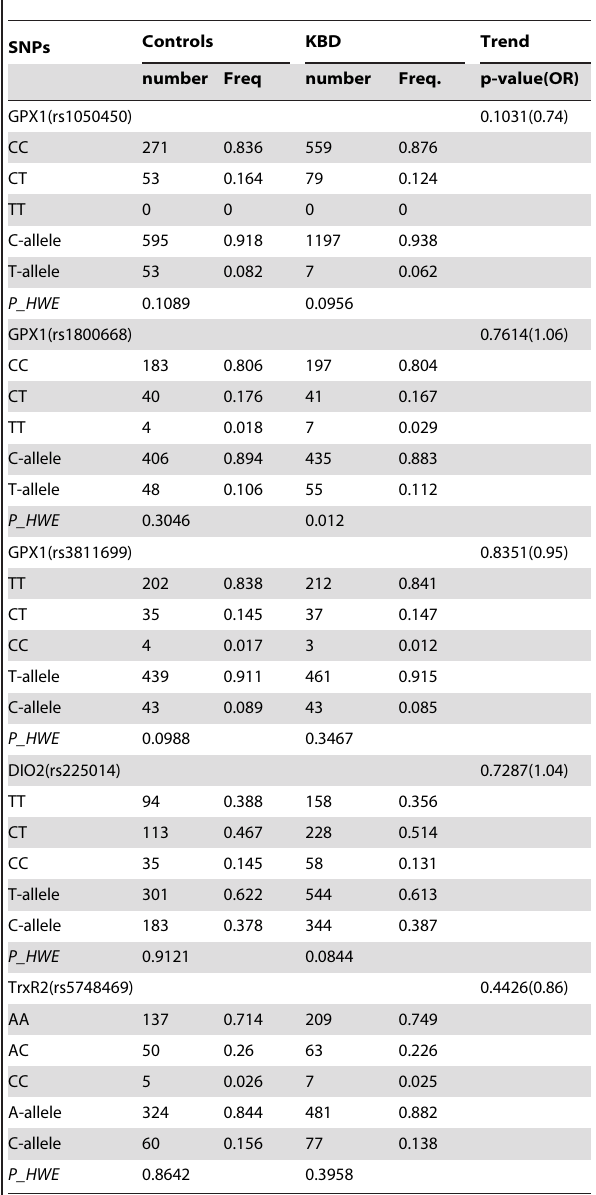
Table 3. Genotype and allele frequencies of polymorphisms across selenoprotein genes in Tibetan.